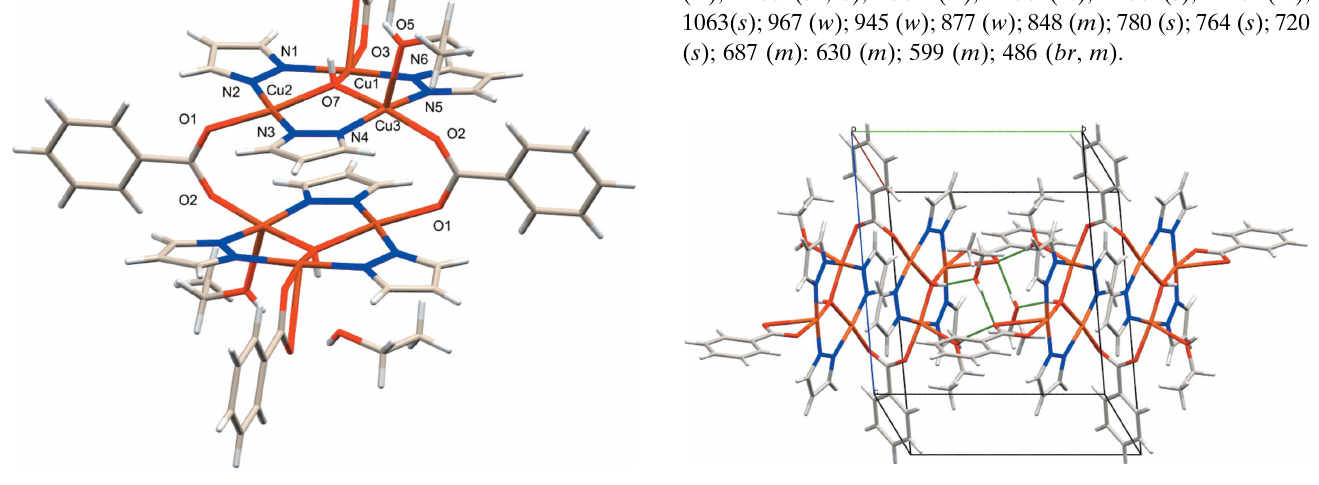
Figure 4 Packing of the molecules of the title compound. O—H (cid:2)(cid:2)(cid:2) O hydrogen- bonding interactions are shown as green dashed